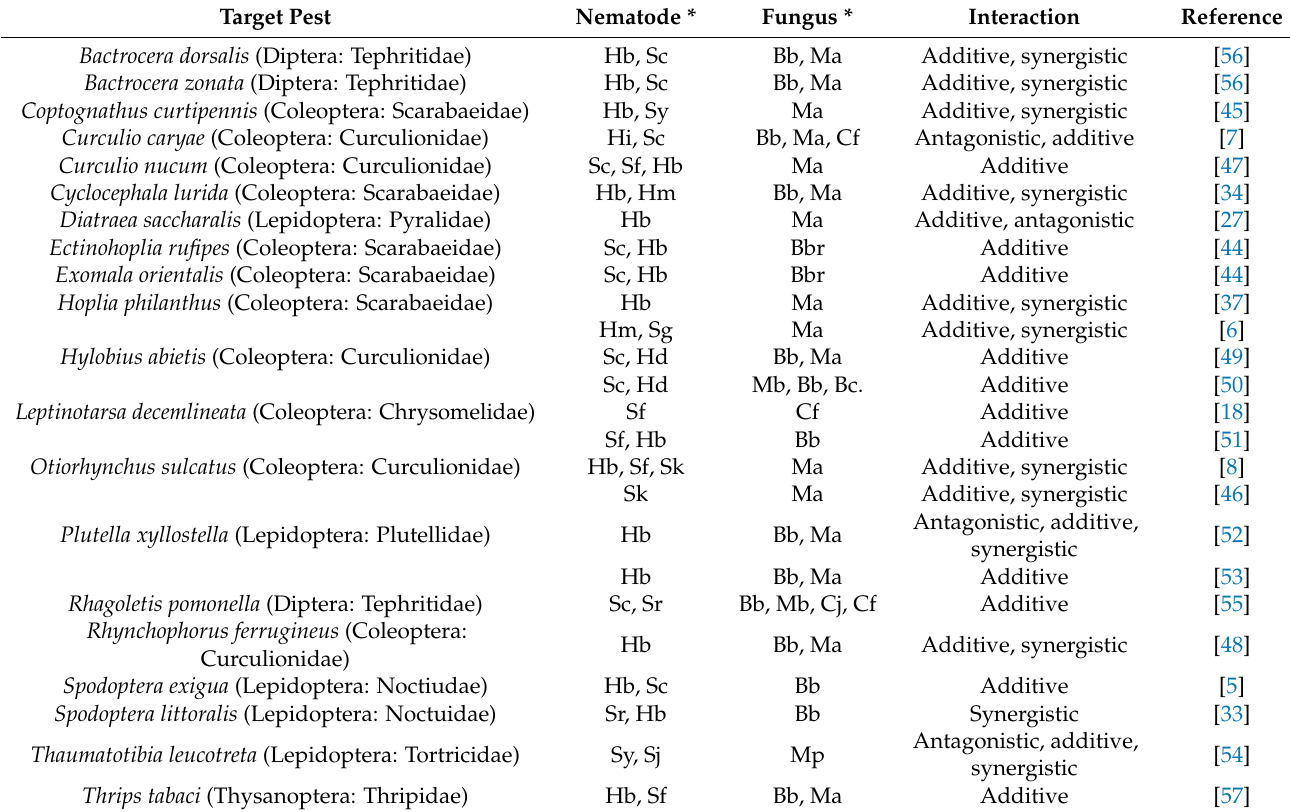
Table 1. The effects of the joint application of entomopathogenic nematodes with entomopathogenic fungi on agricultural